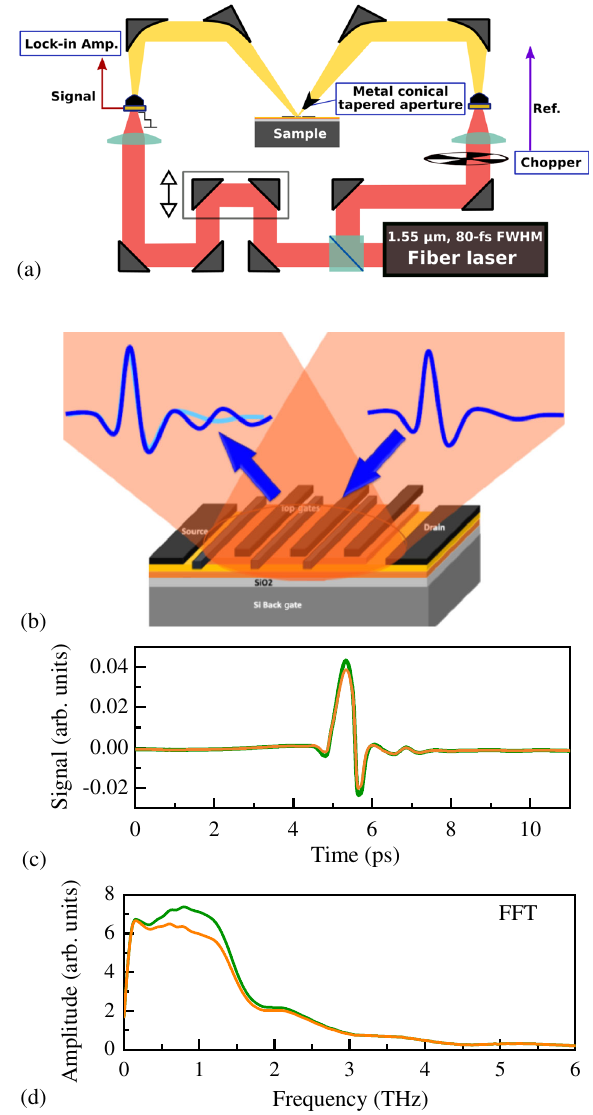
FIG. 3. Measurement setup. (a) THz TDS. (b) Total reflection configuration. The incident THz radiation pulse is linearly polarized. The sample stage is rotated to obtain the radiation polarization perpendicular or parallel to the drain-source direc- tion. (c) Typical time trace for samples with (orange) and without gate biasing (green) in the measurement system are shown in the upper panel. Spectra are obtained by FFT transformation of the same signal in the lower